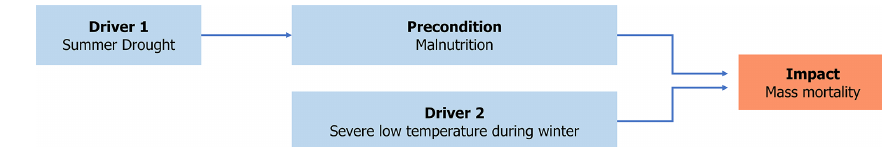
Figure 1. Diagram showing dzud is a preconditioned compound